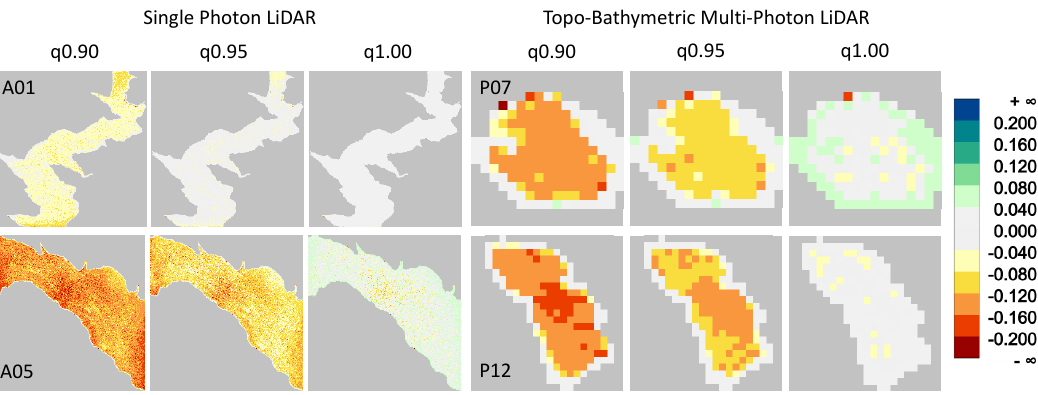
Figure 10. Deviations between reference water level and 10m digital water surface model grids calculated for selected Single- and Multi-Photon LiDAR water bodies and height